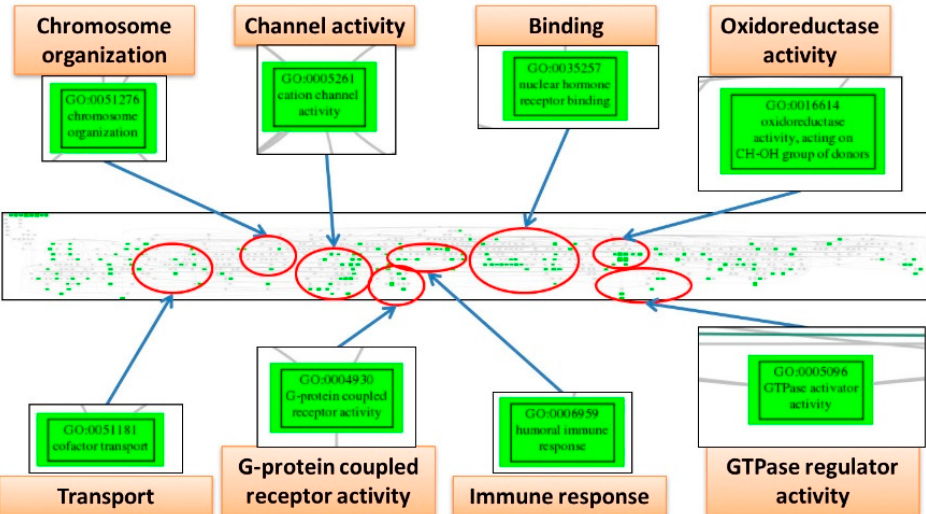
Figure 6. The GO tree of deregulated functions from exploratory factor analysis for endometrioid carcinoma. This figure displays the screenshot of the full Gene Ontology (GO) tree for ovarian endometrioid carcinoma (EC) (middle panel). After mapping to the GO tree, the similar or related GO terms are clustered together. Each cluster is circled (red), and the important deregulated GO terms (green boxes) in the cluster are magnified to view the details. Each cluster is labeled by the common parental GO term (orange rectangle).